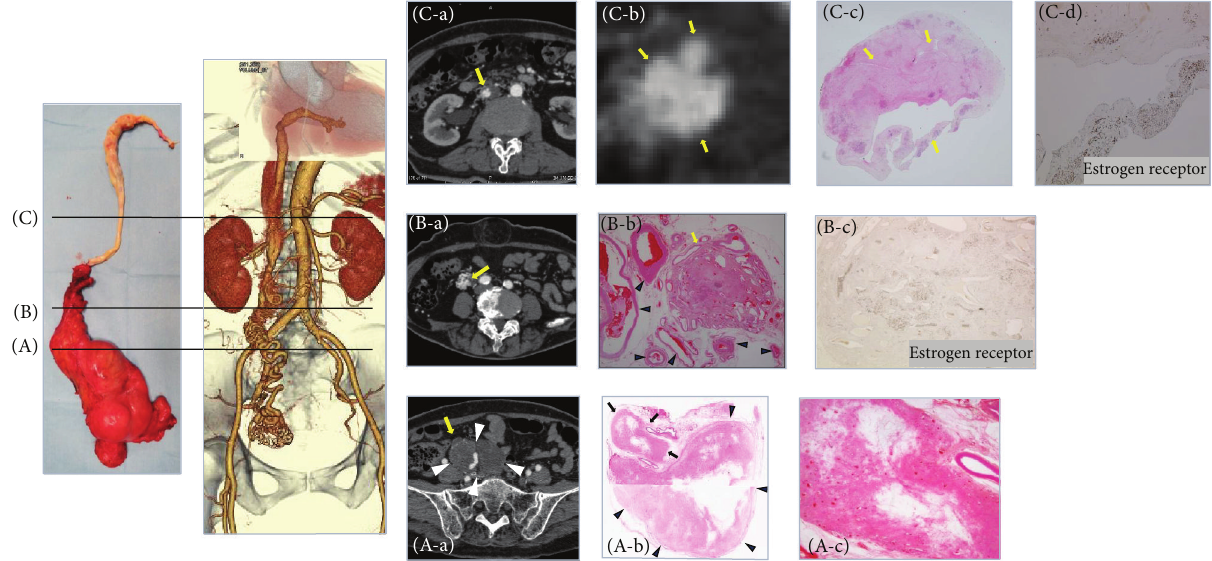
Figure 6: Radiologic-pathologic correlation. (A) The level of the origin of the extrauterine lesion. (A-a) AC-CT image revealed that the origin of the continuous mass extending into the IVC was a small nodule (arrow) on the surface of the uterine tumor (arrowheads); this was determined by referring to MPR images (Figure 2(a) arrows). (A-b) On a photomicrograph at the same level as the AC-CT image, the nodule could be identified as a small nodule of lipoleiomyoma (arrows) on the surface of the uterine lipoleiomyoma (arrowheads). (A-c) No vein wall structure was found around the nodule. (B) The level of the right ovarian vein. (B-a) AC-CT indicated the presence of plexiform arteries along the route of the right ovarian vein (arrow). (B-b) A photomicrograph at the same level showed a large number of vessels (arrowheads) surrounding a bundle of vessels with a small amount of smooth muscle cells (arrow). There was no vein wall structure around smooth muscle cells and hematoxylin-eosin (HE) staining showed no evidence of the tumor component. (B-c) The nuclei of smooth muscle cells stained positive for ER and PR (not shown), which indicated that they were a continuous part of the uterine tumor, but there was no evidence of an intravenous component. (C) The level of the IVC. (C-a) The intracardiac and intracaval components of the tumor appeared as a cord-like mass composed of just a bundle of arteries on the AC-CT image (arrow). (C-b) AC-CT image showed three arteries within the tumor (arrows). (C-c) Histologic examination revealed those components were composed of degenerated smooth muscle cells including several large vessels (arrows). (C-d) The smooth muscle cells stained positive for ER and PR (not